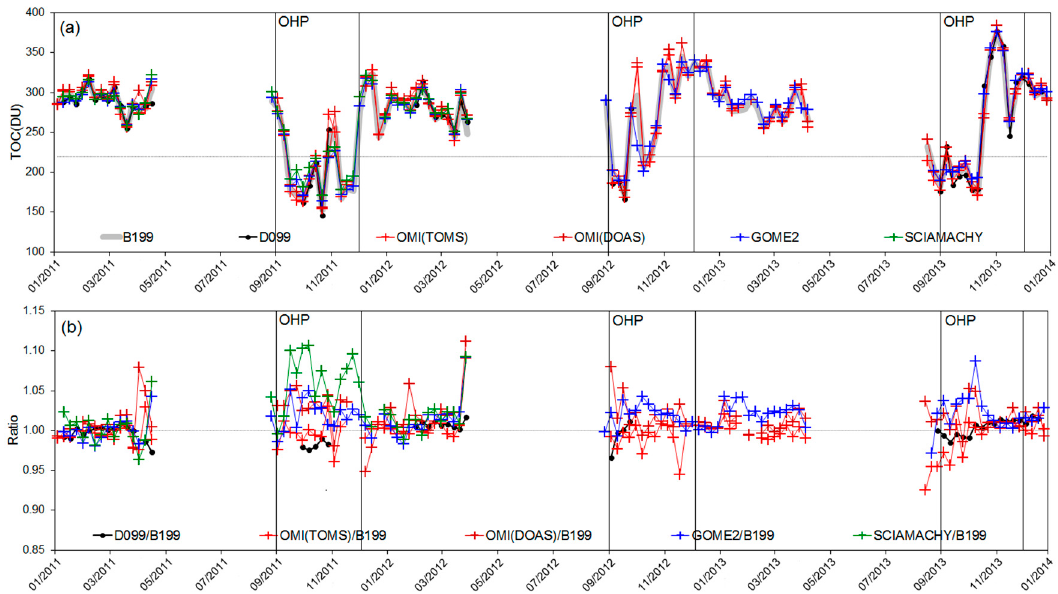
Figure 3. Mean weekly ( a ) total ozone column (TOC) as recorded by the B199 Brewer and D099 Dobson spectrophotometers, and various satellite instruments, i.e., OMI(TOMS), OMI(DOAS), GOME2, and SCIAMACHY; and ( b ) the relative differences between the TOC measurements with reference to the B199 Brewer spectrophotometer at the Marambio Base for the period 2011–2013. OHP stands for the ozone hole period.